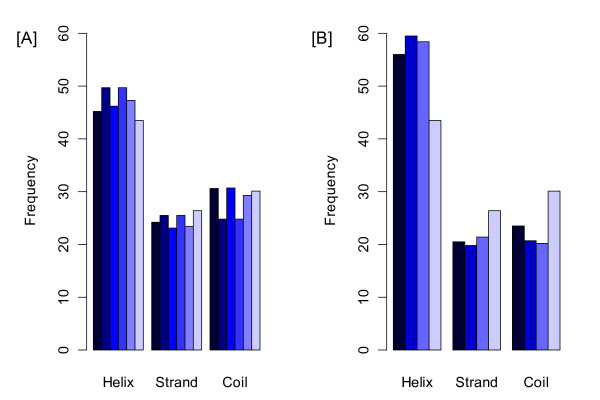
Proportions of sites in different secondary structures: (A) color-coded bars from dark to light blue correspond respectively to the residues coevolving for Grantham distance, volume, charge, all coevolving sites and the whole RBCL sequence; (B) color-coded bars from dark to light blue represent respectively the positively selected sites detected by PAML, FitModel, both and the whole sequence.